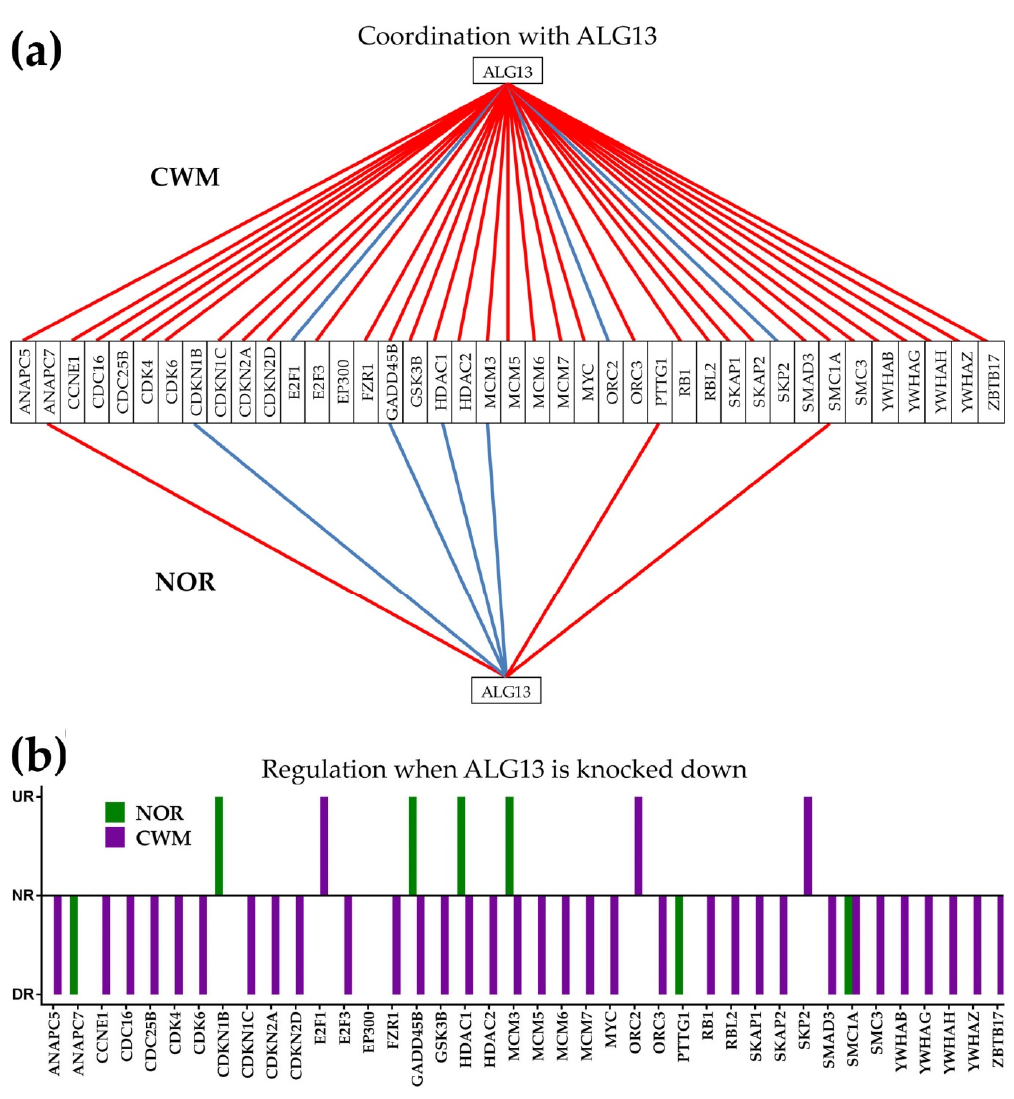
Figure 8. Possible molecular mechanism by which knocking down ALG13 would selectively destroy the CWM cells. ( a ) Expression correlation of ALG13 with cell cycle genes in CWM and NOR. A red/blue line indicates synergistic/antagonistic expression, respectively. Missing line indicates non-significant correlation. ( b ) Possible effects of ALG13 overexpression on the cell cycle genes. UR = upregulated, NR = not regulated, DR = downregulated.